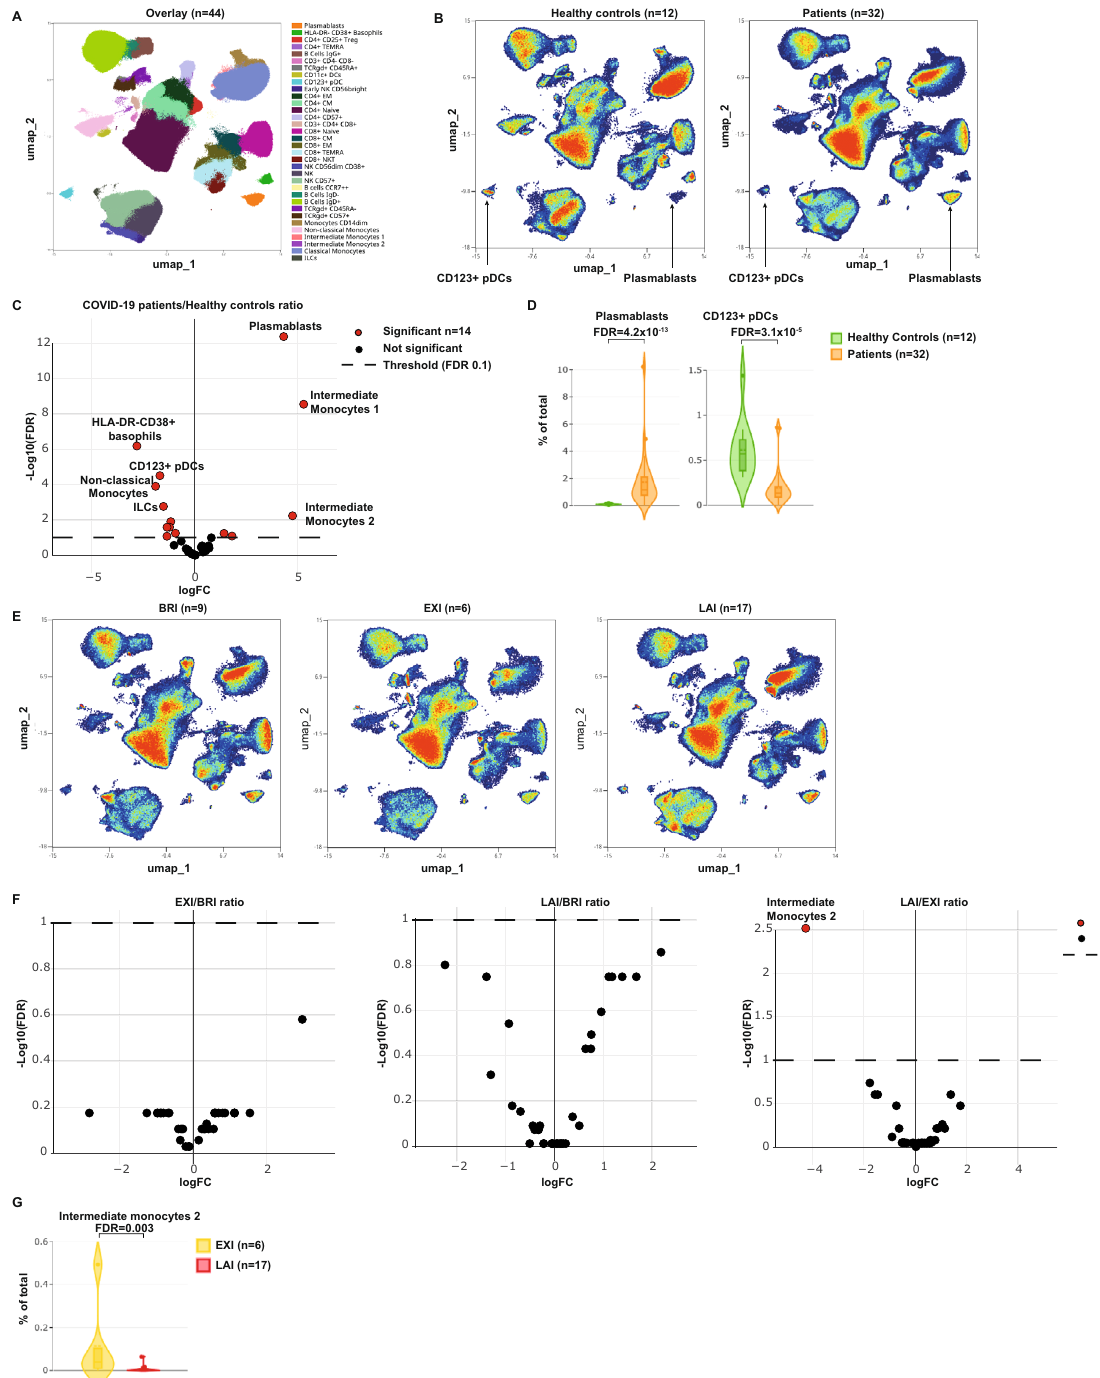
Fig. 6 High-dimensional fl ow cytometry reveals distinct immune subset differences between immunotypes. A Population cluster identi fi cation in high- dimensional 40-color fl ow cytometry data using uniform manifold approximation and projection (UMAP) dimensionality reduction. Visualization is performed on combined COVID-19 patients and healthy control data ( n = 44). B UMAP plots of healthy controls ( n = 12) and all COVID-19 patients ( n = 32). Plasmablast and pDC indicated by arrows. C Volcano plots of the comparison COVID-19 patients/Healthy controls. Positive fold-changes indicate cellular population increases in patients while negative fold-change indicate decreases in patients. D Plasmablast and pDC frequencies in healthy controls and COVID-19 patients show. Violin plots depict the percentage of cells in the total population. False-detection rate (FDR) of population comparisons for plasmablasts is 4.2 × 10 − 13 and for pDC 3.1 × 10 − 5 . E UMAP plots of the three immunotypes (BRI n = 9, EXI n = 6, LAI n = 17). F Volcano plots of the pairwise comparison of immunotypes. Positive fold-change indicates increase in numerator of ratio, while negative fold-change indicates decreases. All patients are from Rotterdam cohort. G Intermediate monocyte 2 frequencies in EXI and LAI patients show. Violin plots depict the percentage of cells in the total population. The violin shapes were de fi ned by kernel density estimation the boxes de fi ne the Q1 to Q3 range while box whiskers indicate min/max. The mean and median are indicated by dotted and solid middle lines, respectively. FDR of population comparison is